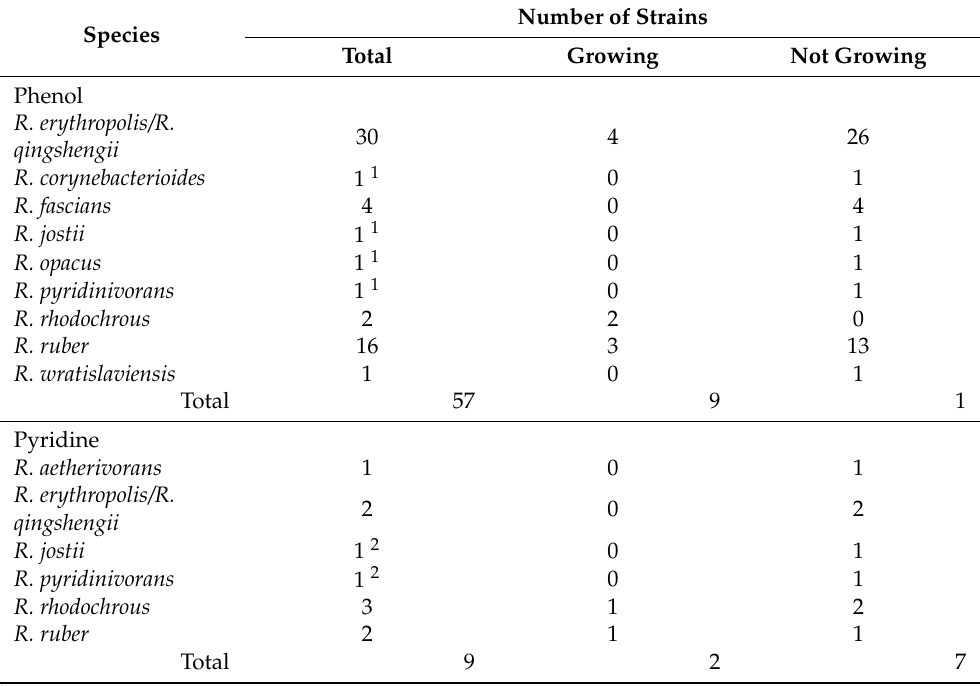
Table 2. Growth of selected Rhodococcus strains in the presence of phenol and pyridine. Number of Strains Species Total Growing